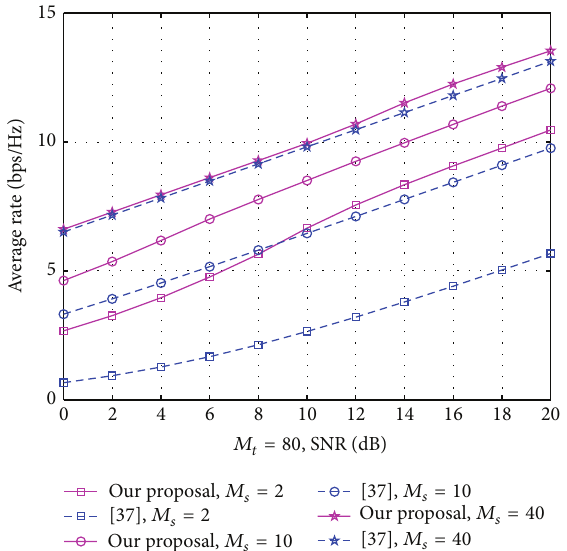
Figure 7: Comparison of CDF versus achievable rates of our proposal with [37] when 𝑀 𝑡 = 80 .